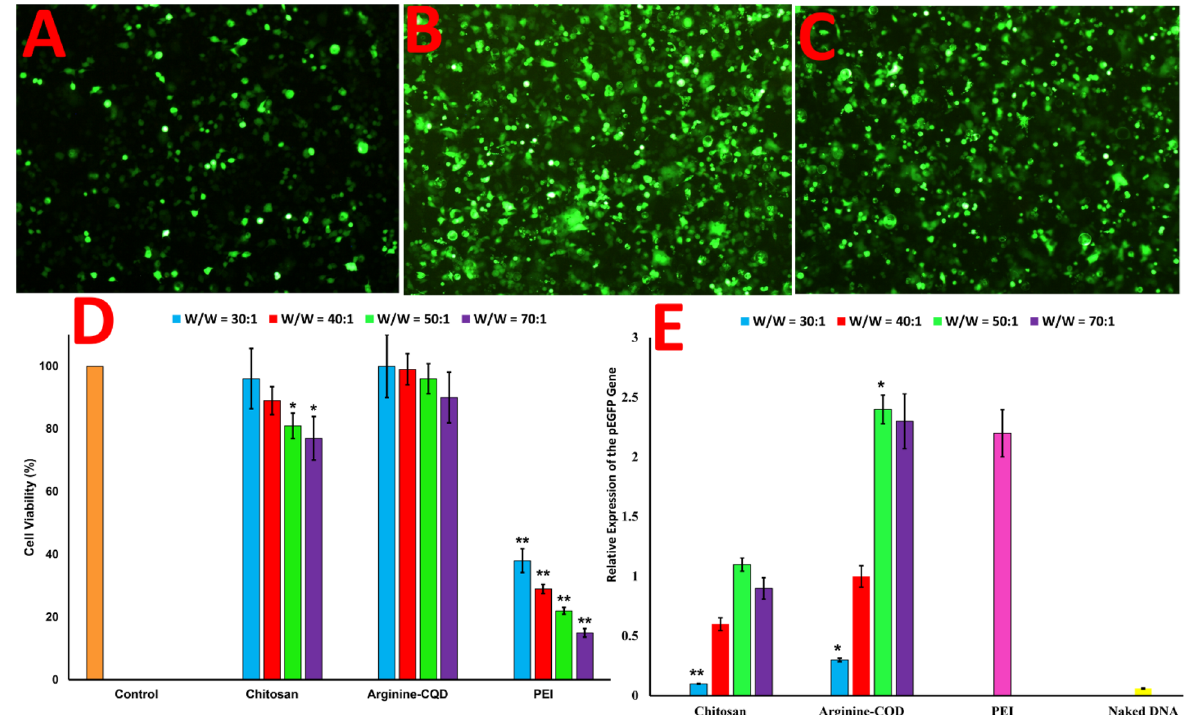
Figure 5. Fluorescence microscopy images of AGS cells transfected with ( A ) chitosan and ( B ) Arginine- CQDs at 50 nanocarrier/pDNA weight ratio (W/W). ( C ) PEI polymer at weight ratio of 1.5, ( D ) cytotoxicity of chitosan, Arginine-CQDs and PEI complex with pEGFP plasmid at W/W ratios of 30, 40, 50 and 70, ( E ) relative gene expression based on real-time PCR for treated cells with chitosan and Arginine-CQDs at W/W ratios of 30, 40, 50 and 70. PEI polymer was used as the positive control (W/W = 1.5) and naked DNA were used as negative control. Data represent the mean ± SD (n = 3, *P < 0.05; **P <